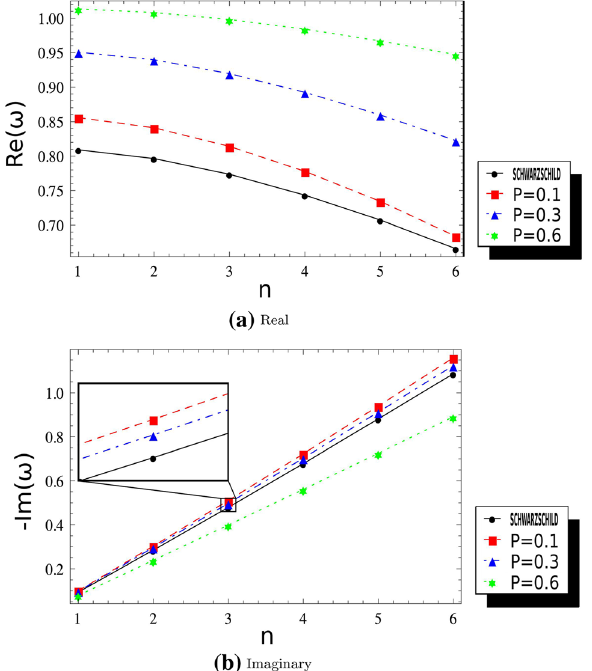
Fig. 6 Behavior of the quasinormal modes, a real part and b imaginary part of ω for l = 4 and P = 0 . 1 , 0 . 3 , 0 . 6